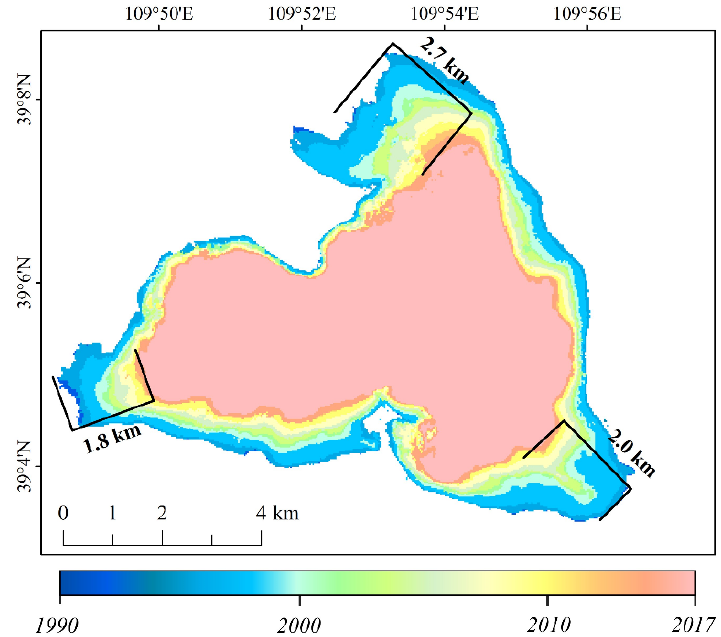
Figure 5. The changes in the shorelines of HN during 1990–2017.